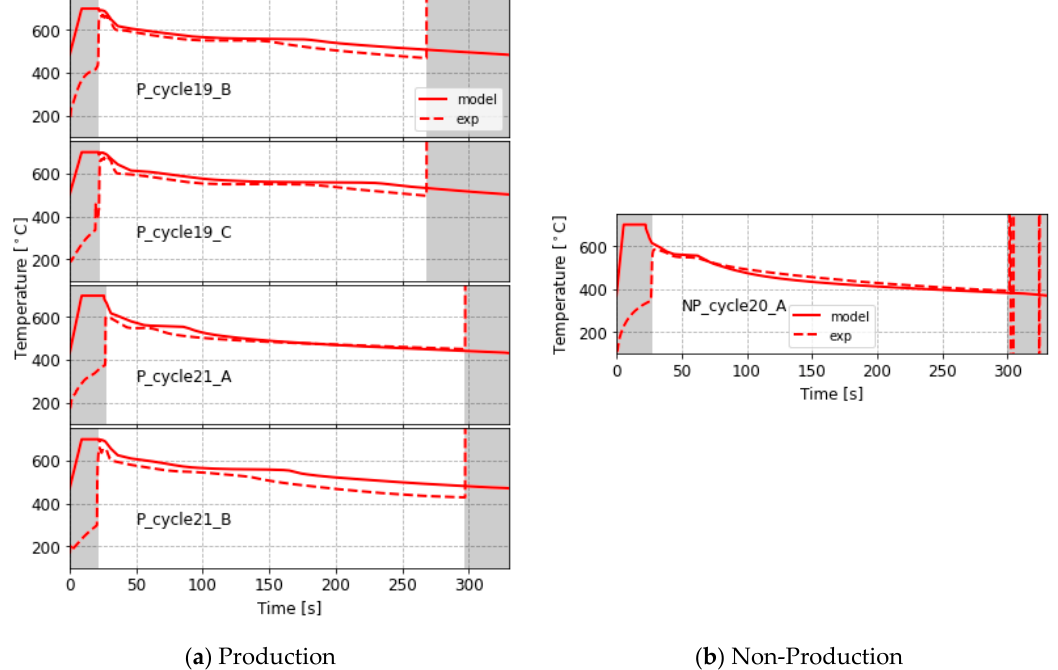
Figure 14. In-wheel temperature comparison for ( a ) production and ( b ) non-production process conditions in Die-A.